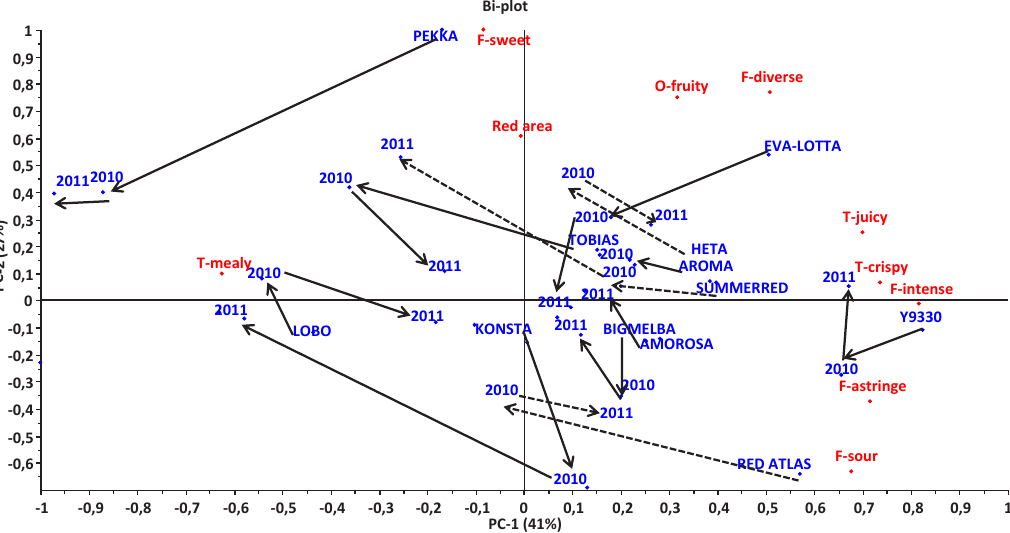
Fig. 4. Apple cultivars over three harvest years visualised with principal component analysis, with the first and